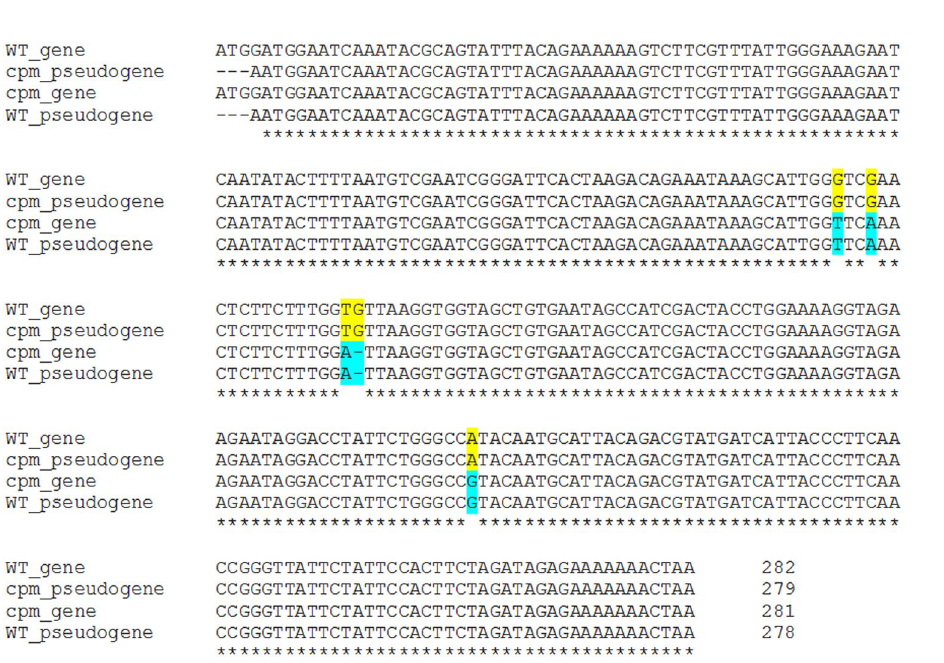
Comparison of wild type sequences of the rpl23 gene and pseudogene. The alignment of the bar- ley wild type sequences of the rpl23 gene and rpl23 pseudogene showed five polymorphic positions in addition to the absence of ATG at the beginning of the rpl23 pseudogene. Notably, these positions coincide exactly with blocks A , B , C , D , E and F mentioned above. The molecular changes identified in the rpl23 gene of cpm seedlings match exactly with the corresponding sequence of the wild type pseudogene. Similarly, the molecular changes identified in the pseudogene of cpm seedlings match exactly with the corresponding sequence of the wild type gene of barley (Fig. 7). In contrast to the high frequency of seedlings carrying the molecular changes corresponding to the genetic variants described above, notably no other polymorphisms were found in the rpl23 gene or rpl23 pseudogene loci. However, two different polymorphisms were found in both amplicons, but outside the gene or the pseudogene regions. One of them was a C302T substitution in the rpl23 amplicon, which was found in only one seedling. The other one, which was also found in only one seedling, was a T856C substitution in the rpl23 pseudogene amplicon. Coexistence of rpl23 gene and rpl23 pseudogene polymorphisms in individual seedlings.